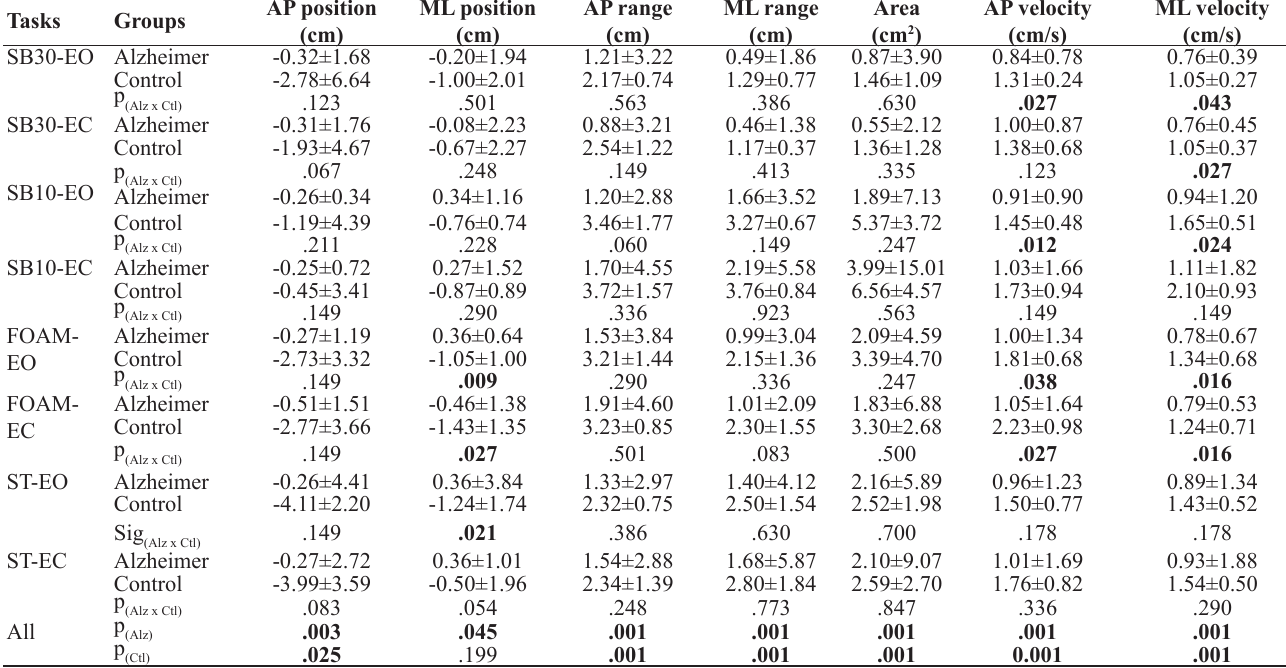
Table 2. Median ± interquartile range of balance values during different tasks. Tasks